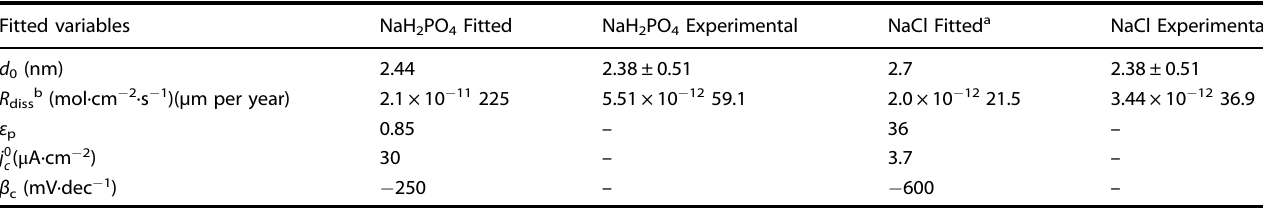
Table 2. Variables obtained by fi tting simulation of j hf to experimental PDP in 0.62 M NaH 2 PO 4 and 3.5 wt% NaCl. Fitted